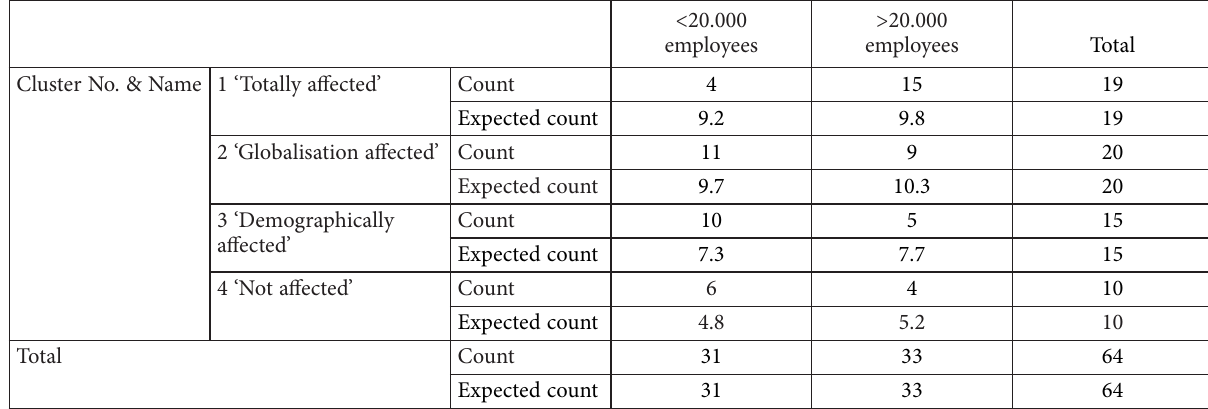
Table A1. Contingency table for cluster solutions and company size differentiated by number of employees (<20.000 and >20.000)